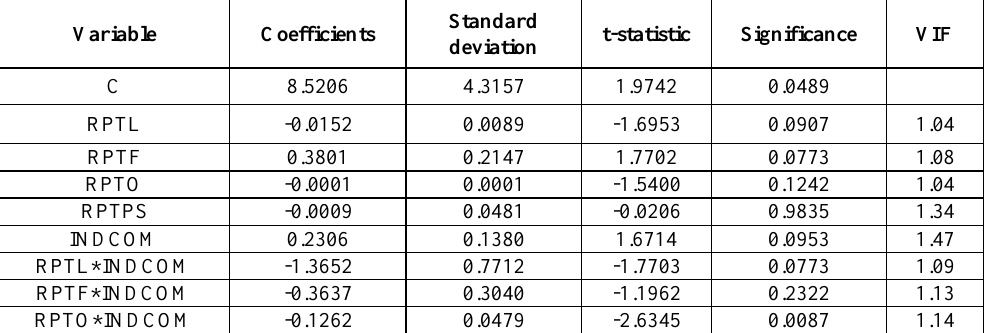
Table 6. The results of the third model (dependent variable is Tobin's